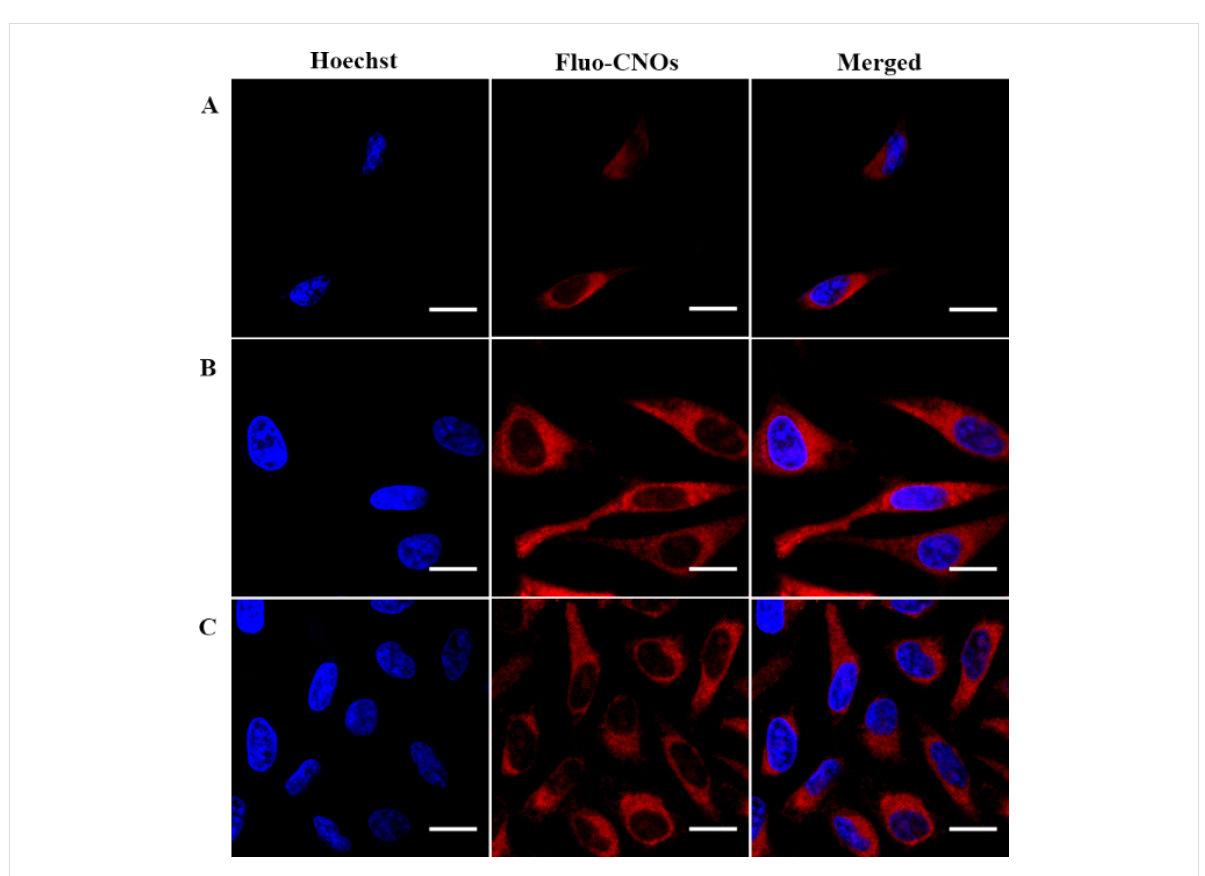
Figure 8: Cellular uptake and localization of fluo-CNOs in HeLa cells in acidic conditions (PBS, pH 4.5) observed by confocal fluorescence microsco- py after incubation for 2 h (A), 12 h (B) and 48 h (C), respectively. Scale bars = 20 μ